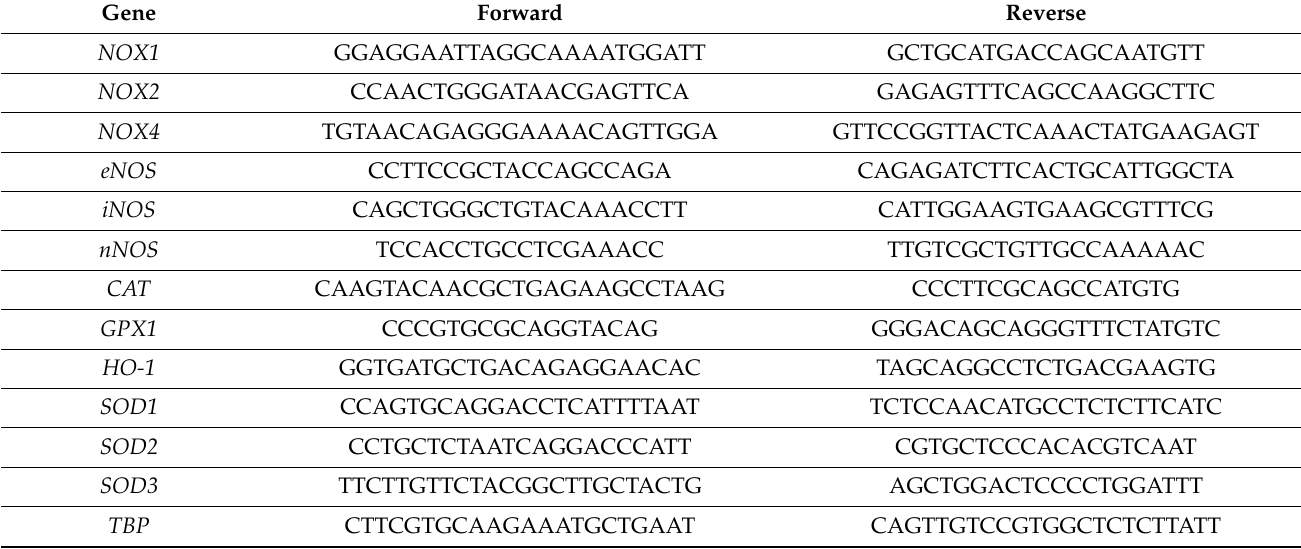
Table 1. Primer sequences used for quantitative PCR